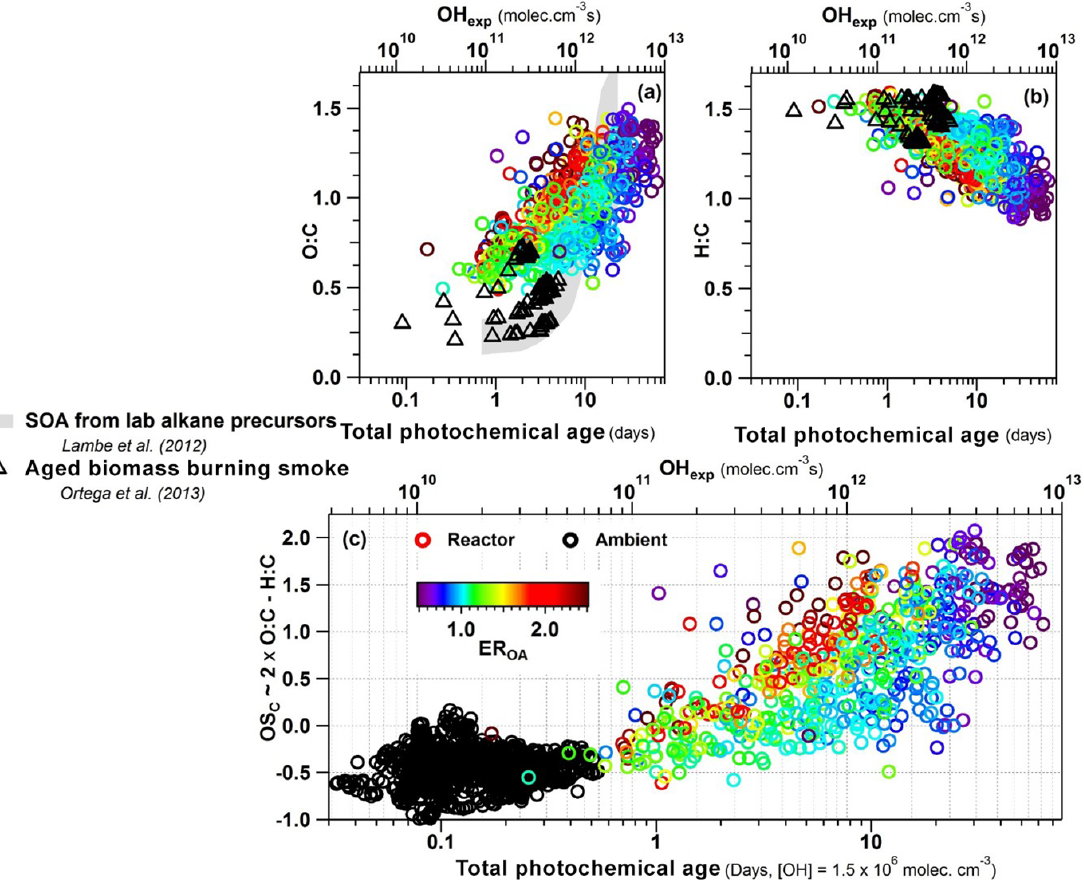
Figure 8. (a) Oxygen to carbon (O:C) and (b) hydrogen to carbon (H:C) elemental ratios for OA mass measured from the reactor vs. total photochemical age in days (at OH = 1 . 5 × 10 6 molec.cm − 3 ) . Results using similar reactors for alkane oxidation from Lambe et al. (2012), and for aging of biomass burning smoke (Ortega et al., 2013) are also shown. (c) Average oxidation state (OS C = 2O:C-H:C) vs. OH exp . Data are colored by the relative organic enhancement (ER OA = reactor OA / ambient